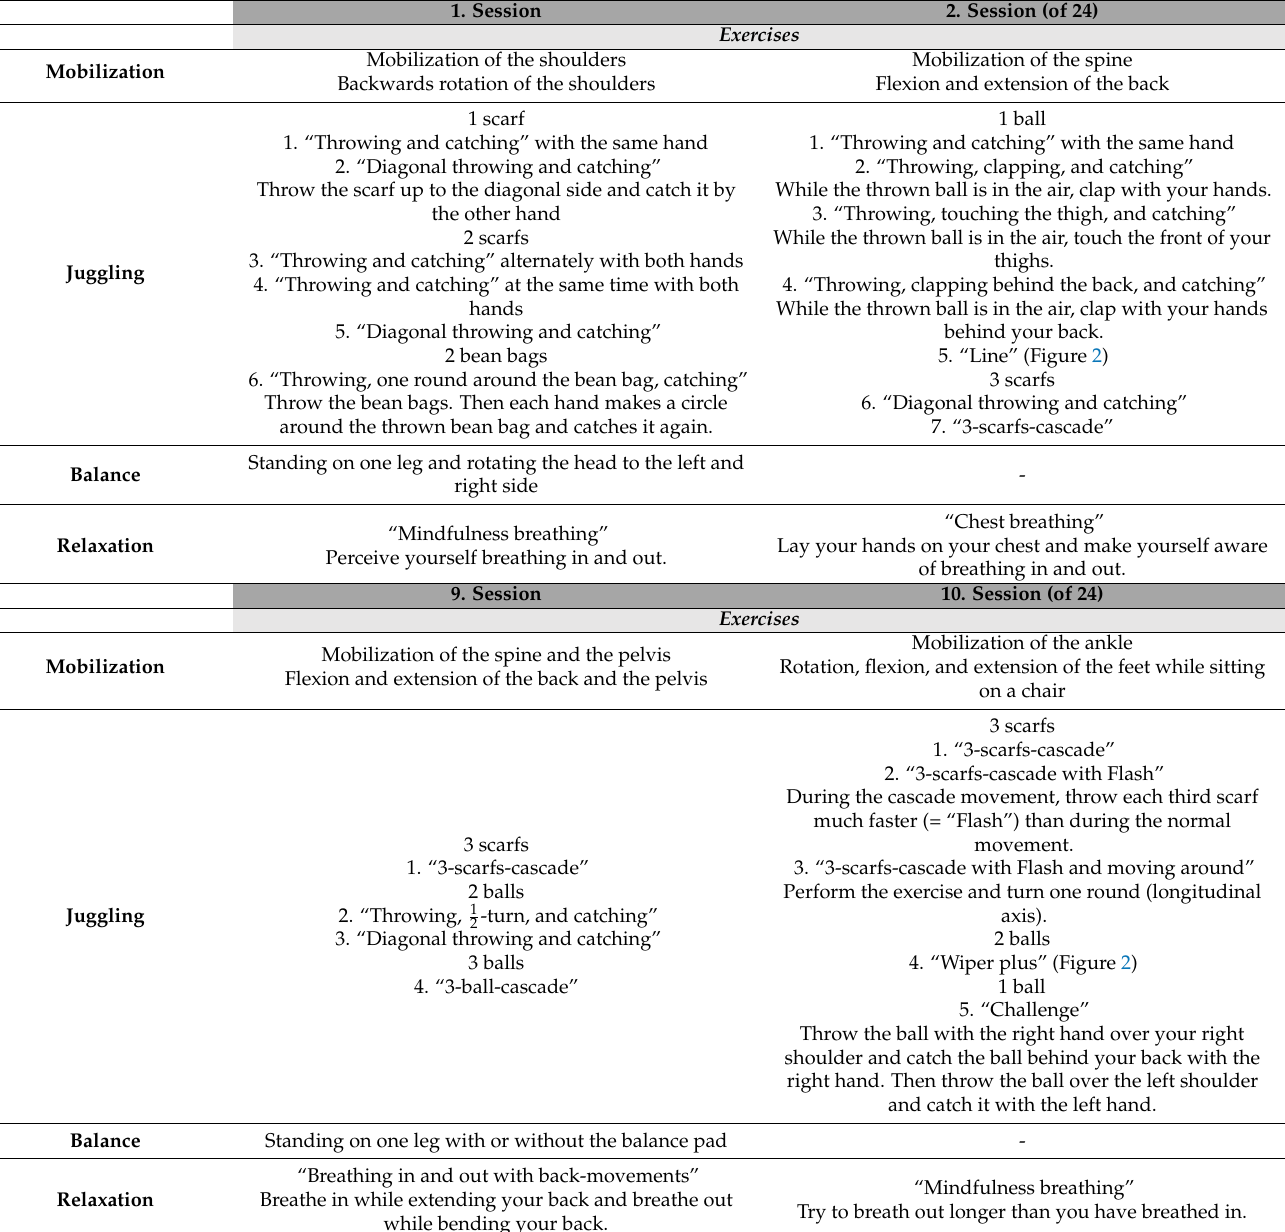
Table 1. Examples for the physical activity break sessions for the three different weeks of training. 1.